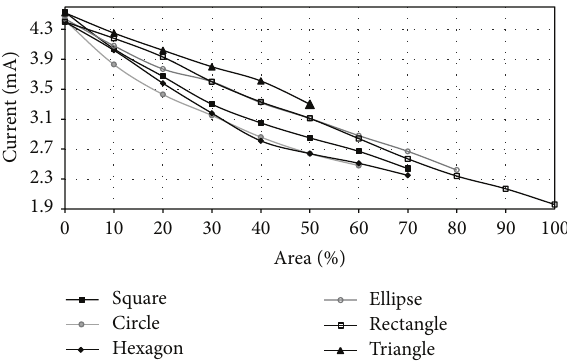
Figure 6: Comparison of current values obtained for opaque areas on light